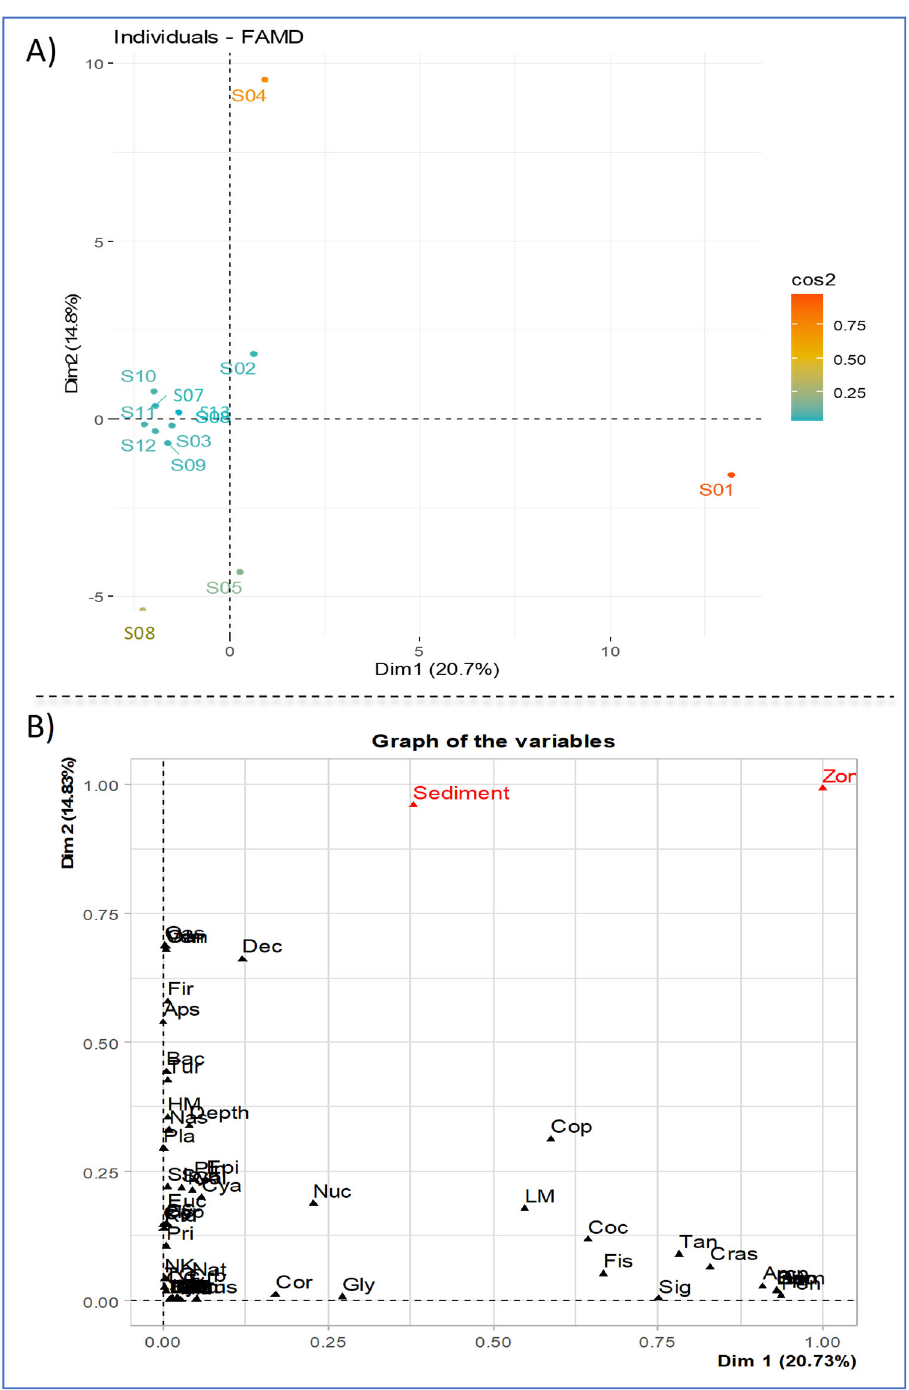
Figure 7. ( A ) Factorial analysis for mixed data (FAMD) showing the plots of sampled stations and, ( B ) the plots of species and variables (depth, sediment types, and estuarine zones) of the sampled stations.